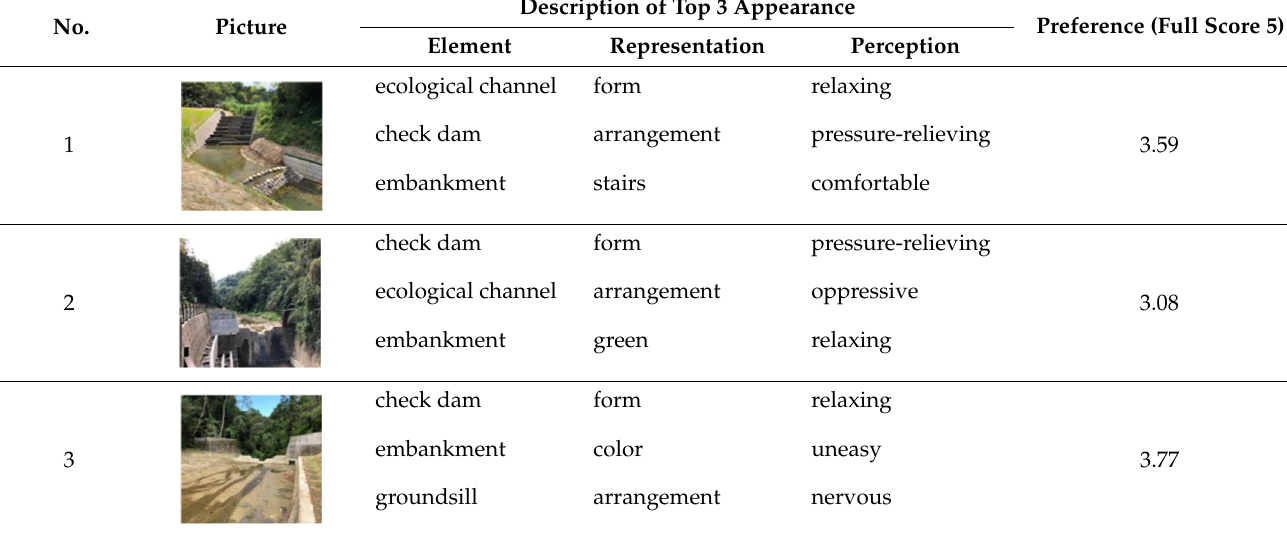
Table 2. CEM results of the “Renovation Project of Sijiaolin Stream.”.